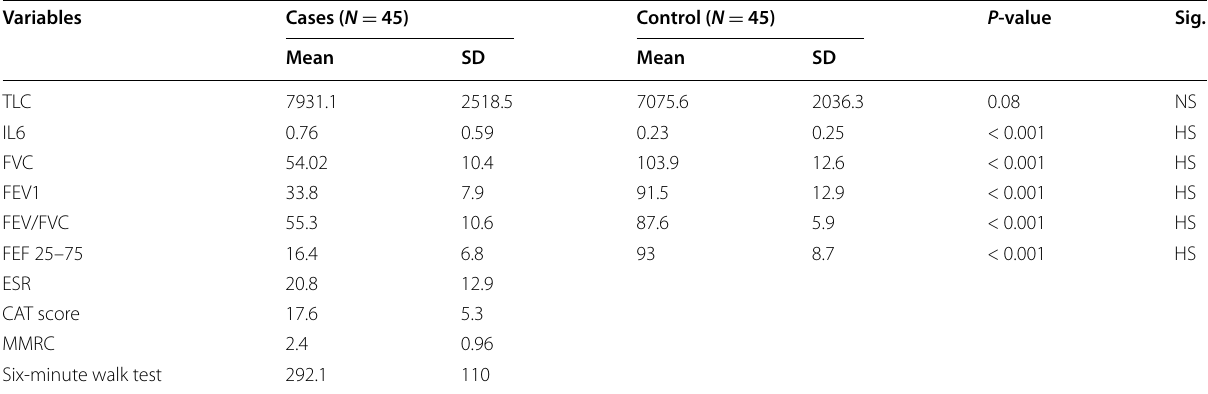
Table 2 Comparisons of laboratory investigations, pulmonary function test parameters, and different variables in different study groups Variables